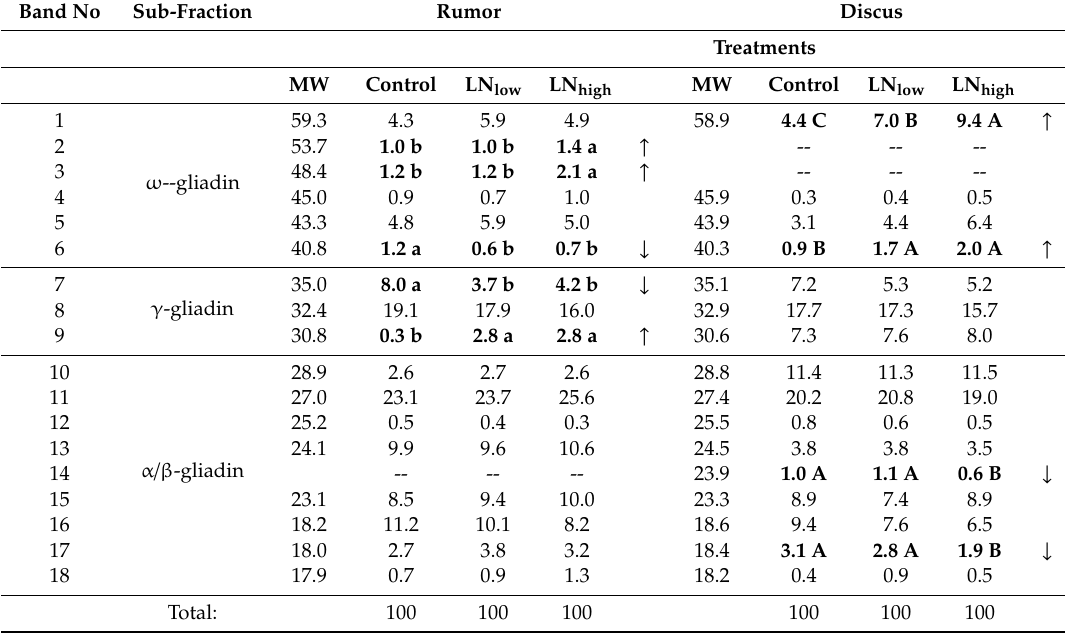
Table 3. Relative protein concentration (% of total lane intensity) of gliadin bands in response to late N fertilization for the two cultivars Rumor and Discus.